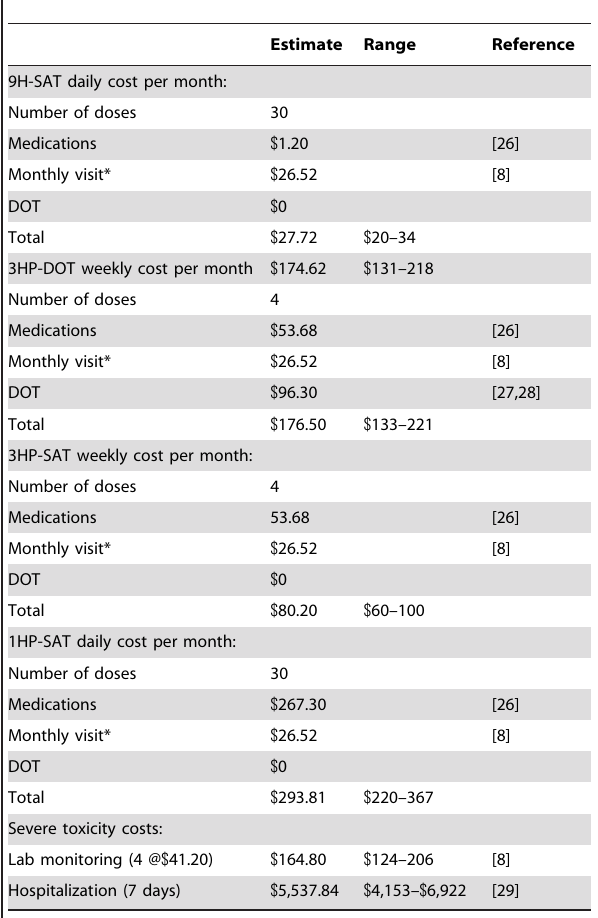
Table 3. Costs in US $ associated with treating latent TB infection.